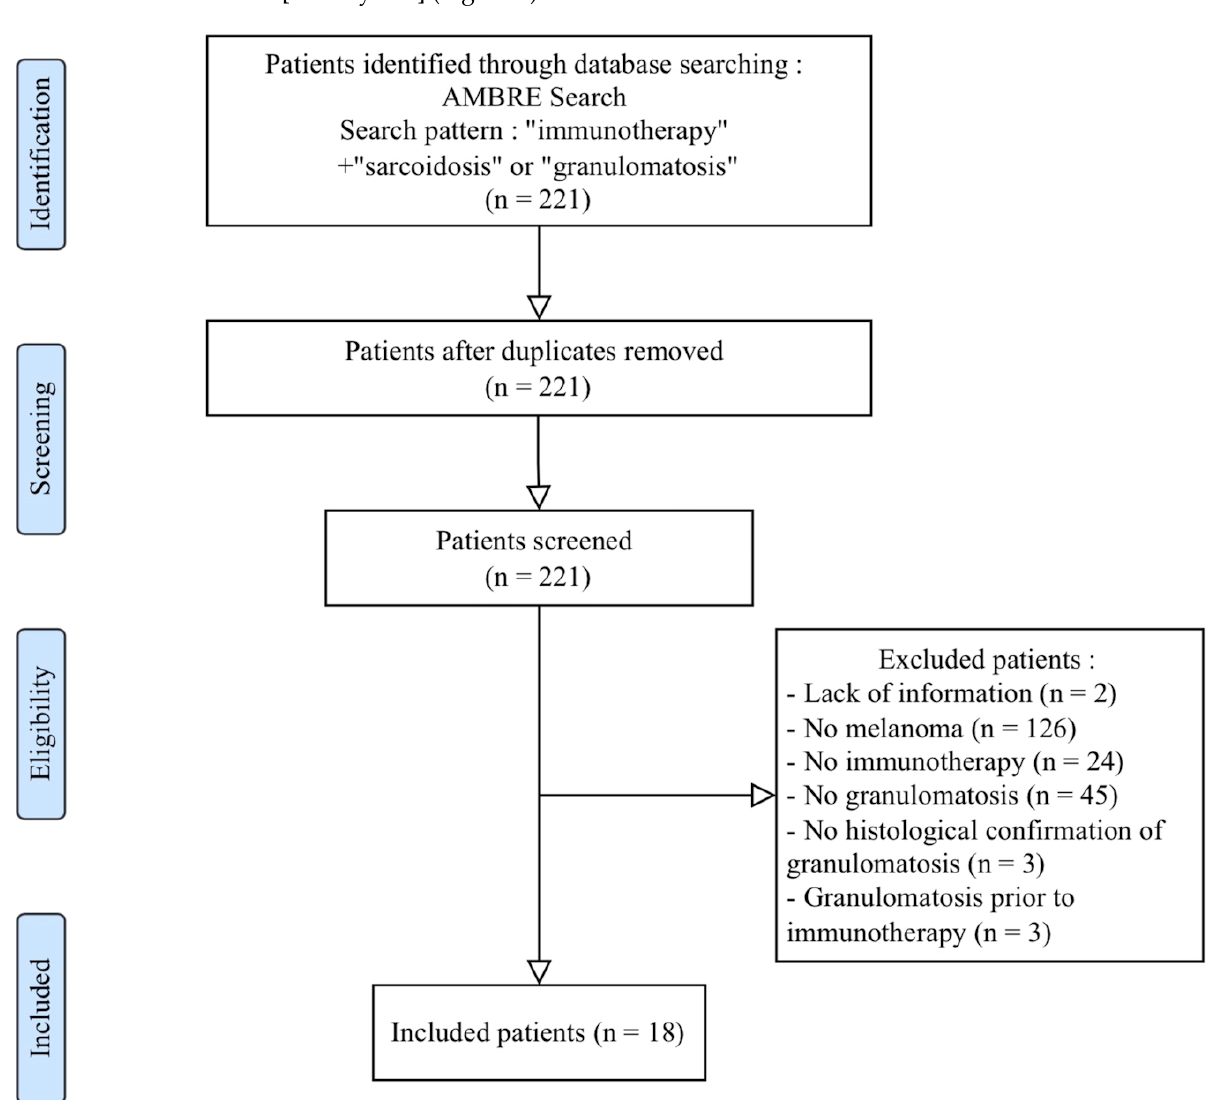
Figure 1. PRISMA study–Patient selection flow chart. The female-to-male ratio was 1.6. Patient characteristics are reported in Table 1. Three patients (16.7%) had stage III and 15 patients (83.3%) stage IV melanoma. Sixteen patients received immunotherapy for unresectable melanoma: twelve as a 1st-line treatment and four as 2nd- or 3rd-line treatment. Two patients with stage IIIC and stage IV melanoma (TxN0M1d) received adjuvant immunotherapy after lymph node resection and neuro- surgery followed by conformal radiotherapy under stereotactic conditions,